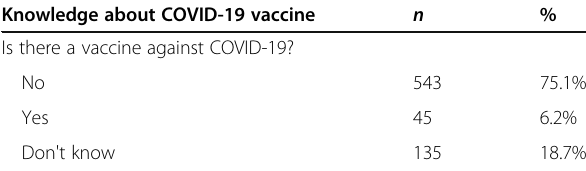
Table 2 Knowledge about COVID-19 vaccine ( N =